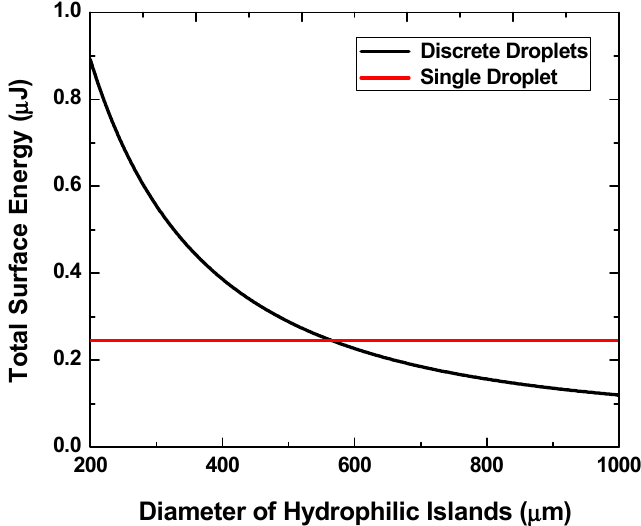
Figure 3. Interface energies of the single-droplet state and the multi-droplet states versus pattern